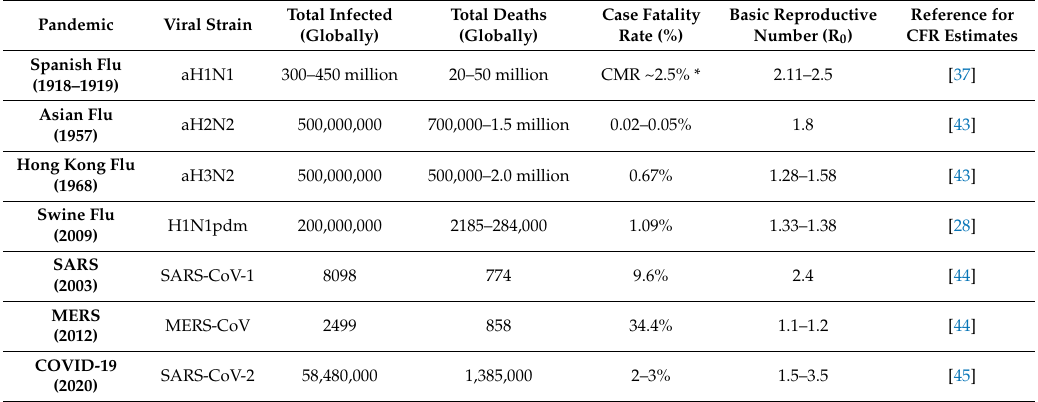
Table 2. Comparison of influenza and coronavirus pandemics of the 20th and 21st centuries.